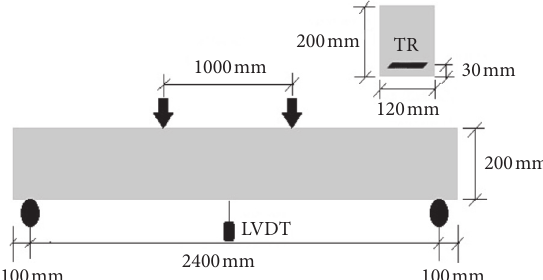
Figure 3: Four-point bending test setup of the reinforced